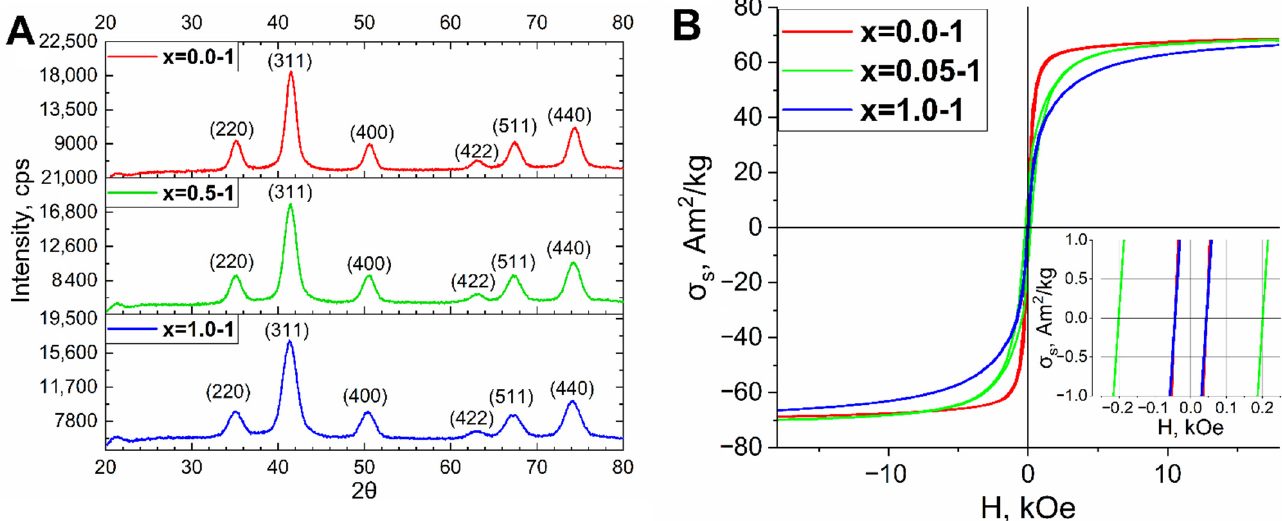
Figure 3. XRD data ( A ) and magnetic properties ( B ) for the MNP of x = 0.0-1; x = 0.5-1 and x = 1.0-1. The elemental analysis of the ferrite MNP was conducted using the MS AES method. Table 1. XRD data for the synthesized samples .